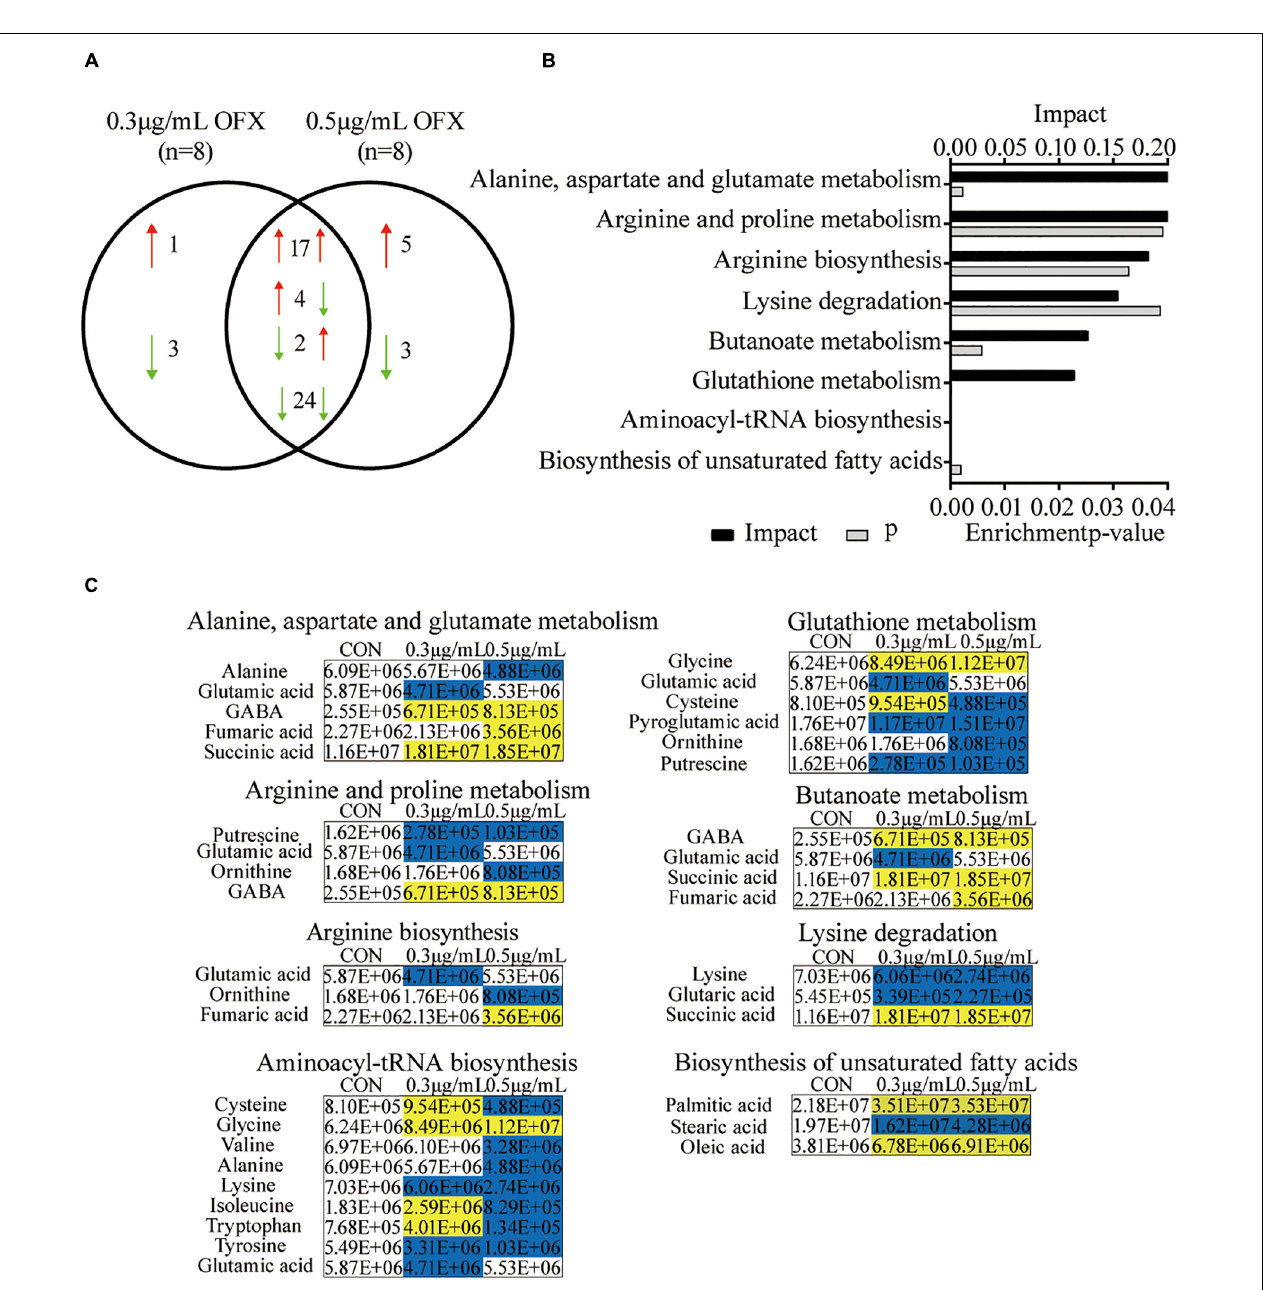
FIGURE 4 | Pathway analysis of differential metabolites upon OFX treatment (A) Metabolites that were shared between the control, 0.3 µ g/ml OFX, and 0.5 µ g/ml OFX groups and their unique metabolites. (B) Enriched pathways by the shared metabolites. The metabolites of differential abundance were selected and analyzed in MetaboAnalyst to enrich pathways. Seven pathways that had significant difference ( P < 0.05) were enriched and sorted by their weights (impact). (C) Differential metabolites in the enriched